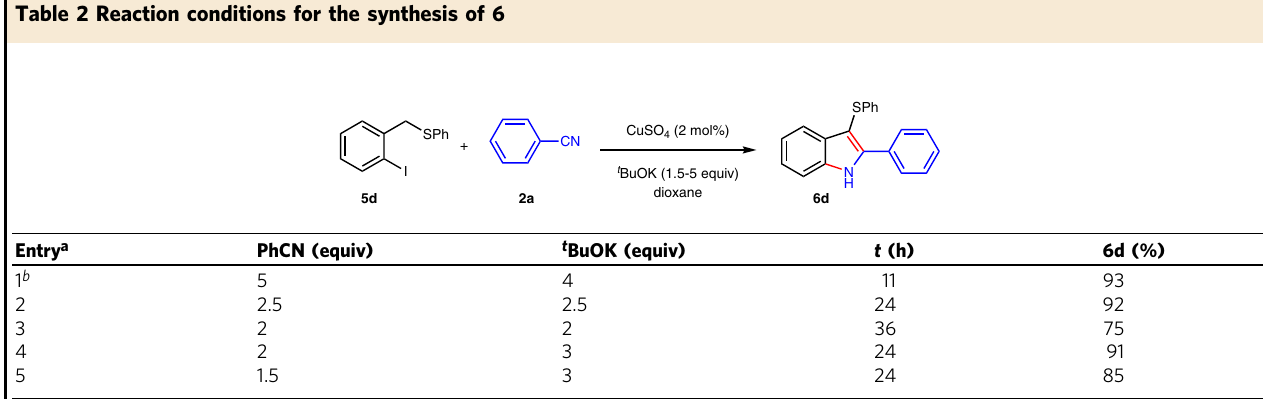
Table 2 Reaction conditions for the synthesis of